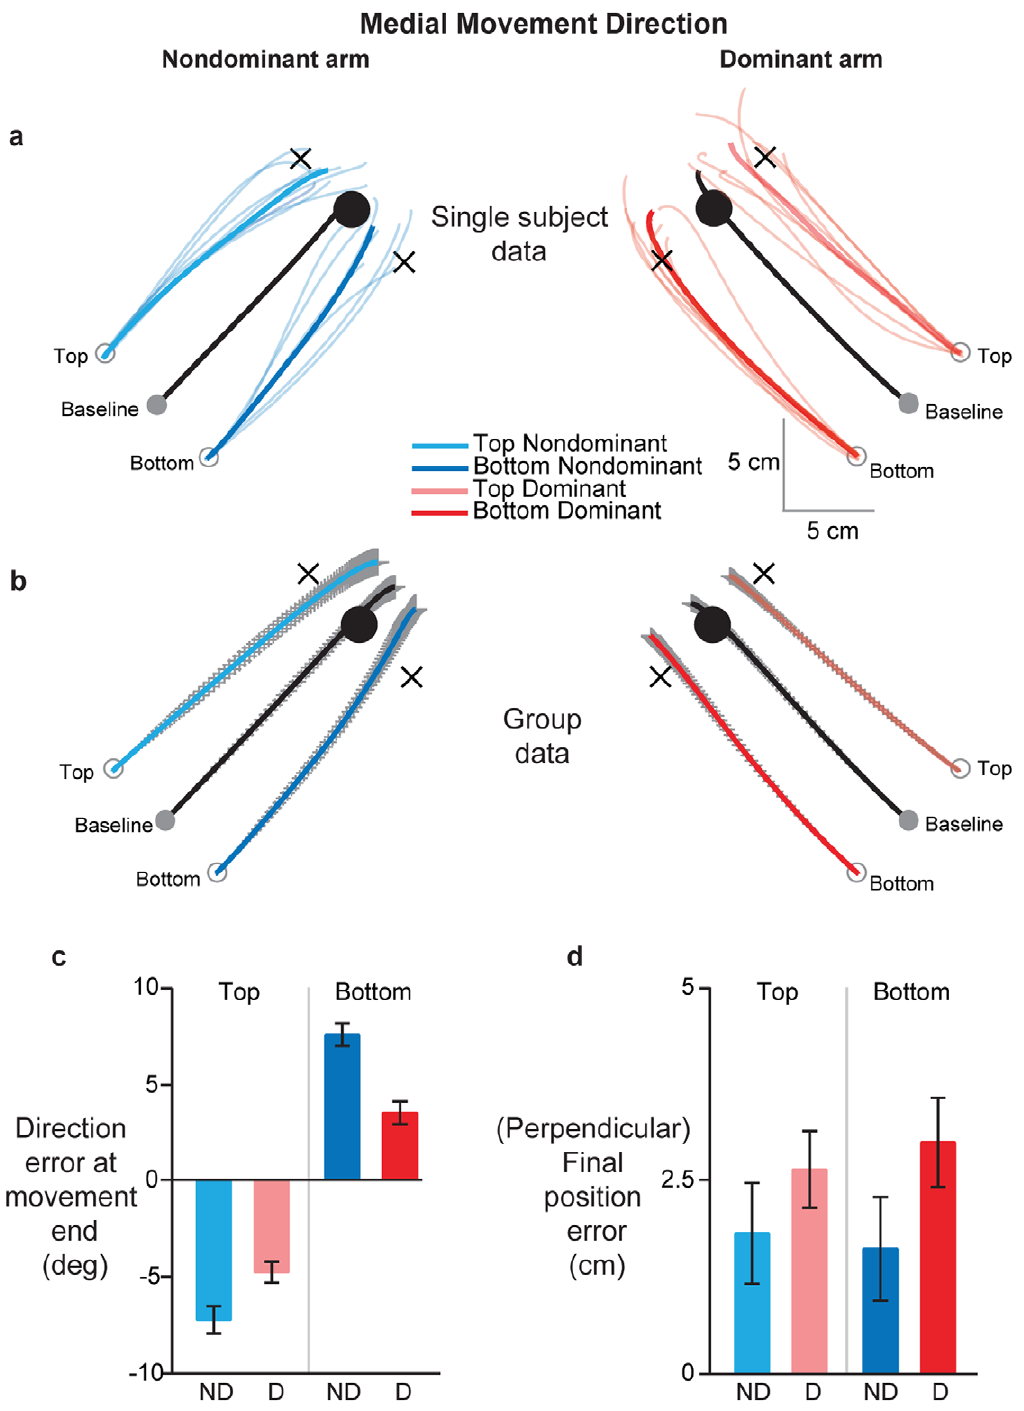
Figure 2. Effects of covertly shifting starting hand position orthogonally on dominant (red) and non-dominant (blue) arm movements in the medial direction. (A) Hand trajectories for a single subject. Thin colored lines show individual probe trials, while thick colored lines show the mean of these individual trajectories. Light and dark colors show movements from the top and bottom start positions respectively. Thick black lines represent mean baseline movements. Black crosses represent virtual targets for the shifted start locations, parallel to baseline target direction and at the same distance as the baseline target. Note that subjects saw only the baseline start and target positions. (B) Mean hand trajectories across all subjects from the baseline and shifted start locations. Colors and line types represent the same information as in 1A . Gray lines represent SE. (C) Mean direction error at movement end and (D) Mean final position error relative to the baseline target across all subjects, separated by start location [top (light colors), bottom (dark colors)] and arm [dominant (red), non-dominant (blue)]. Error bars represent SE.